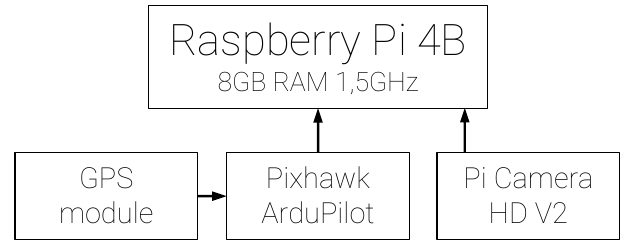
Figure 11. GSOE hardware scheme.